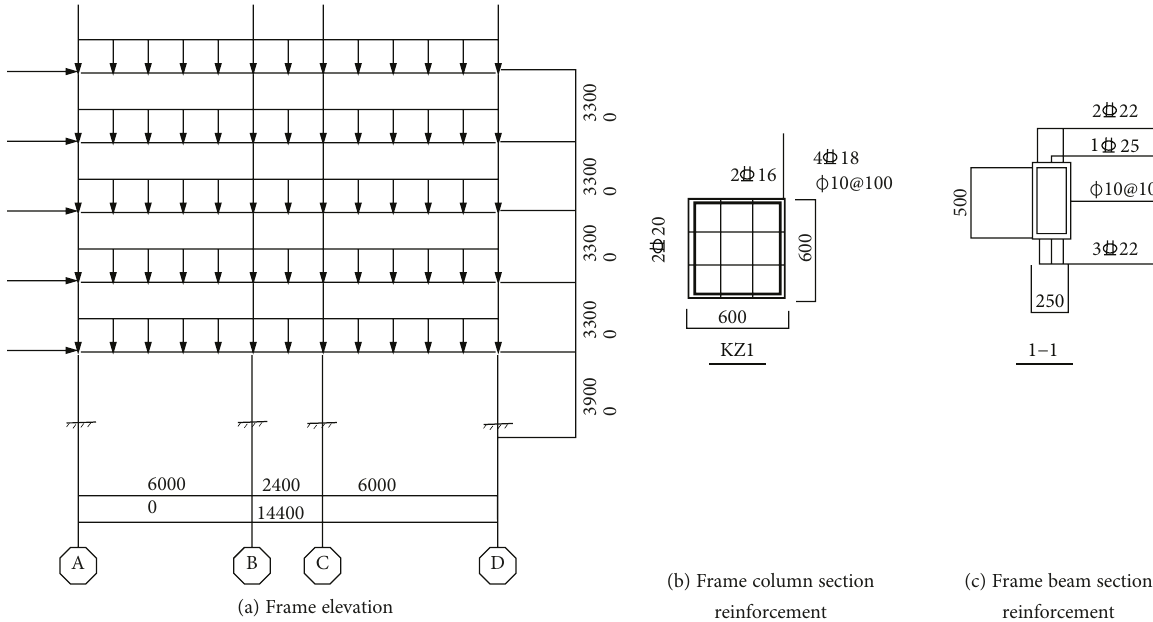
Figure 7: Elevation and reinforcement fi gure of a